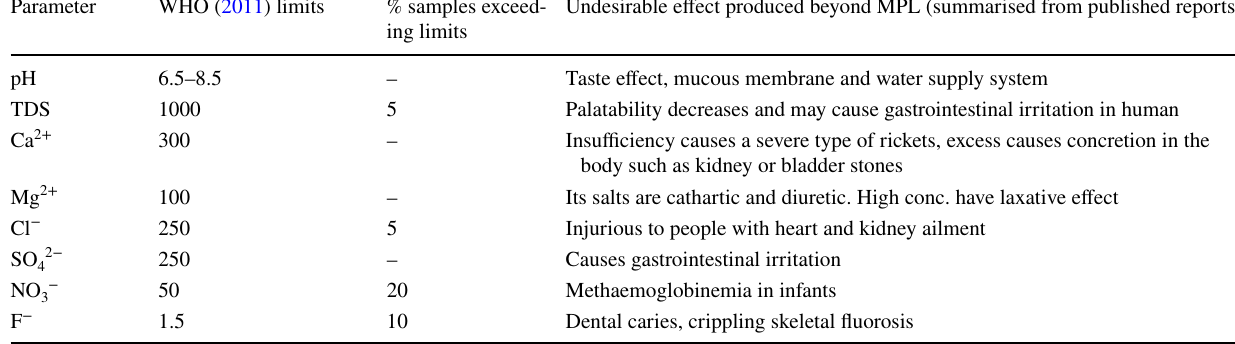
DL desired limit, MPL maximum permissible limit, all parameters expressed in mg/L